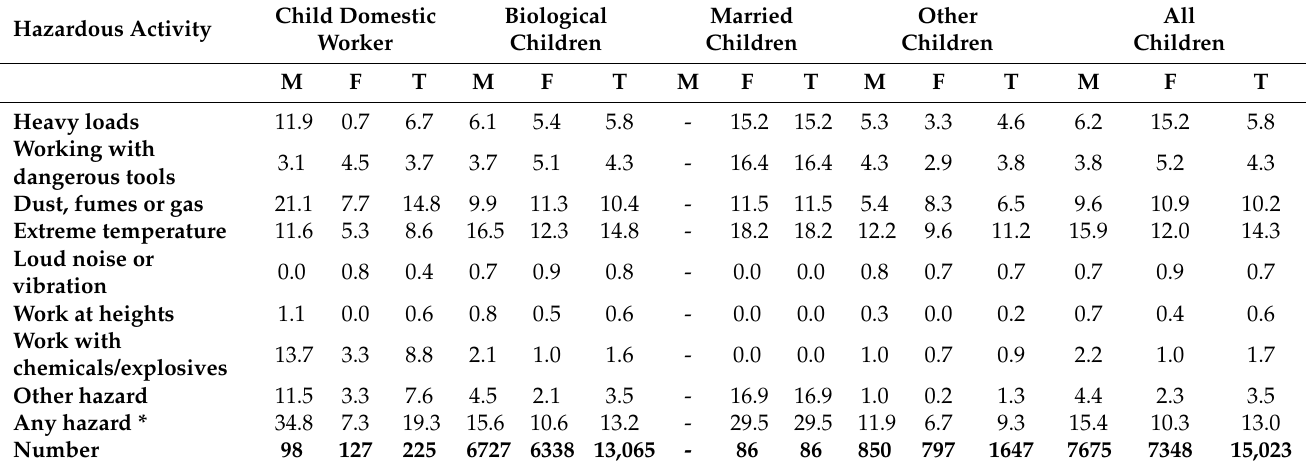
Table 6. Proportion of Children engaged in Hazardous working conditions ( N = 15,023,